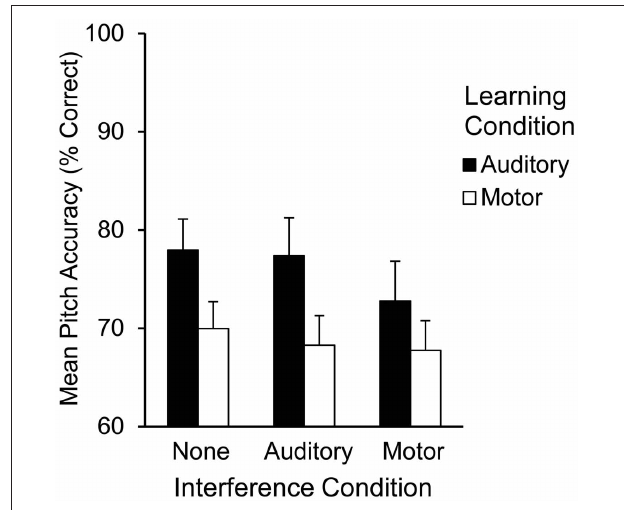
FIGURE 1 | Mean pitch accuracy (% correct pitches) during Recall by learning condition and interference condition in Experiment 1.